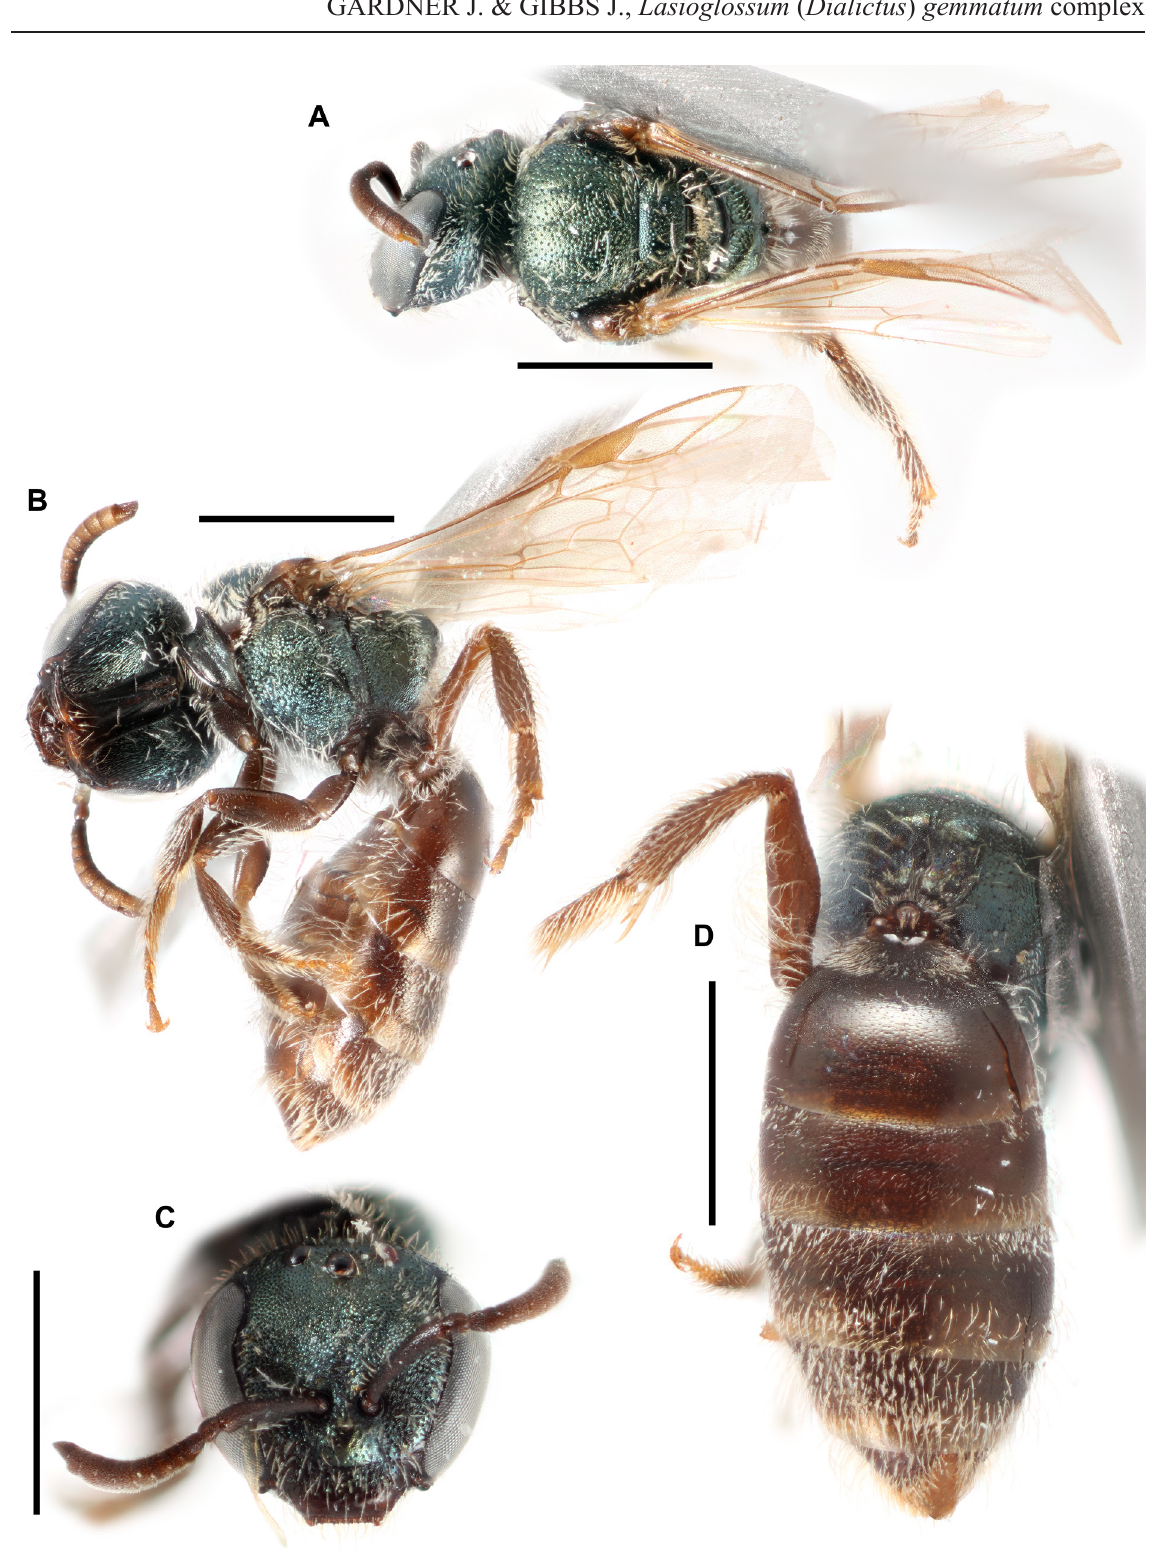
Fig. 6. Lasioglossum ( D .) carlinvillense Gibbs, 2009, ♀, holotype (PCYU). A . Dorsal habitus. B . Lateral habitus. C . Face. D . Metasoma and propodeum. Scale bars = 1